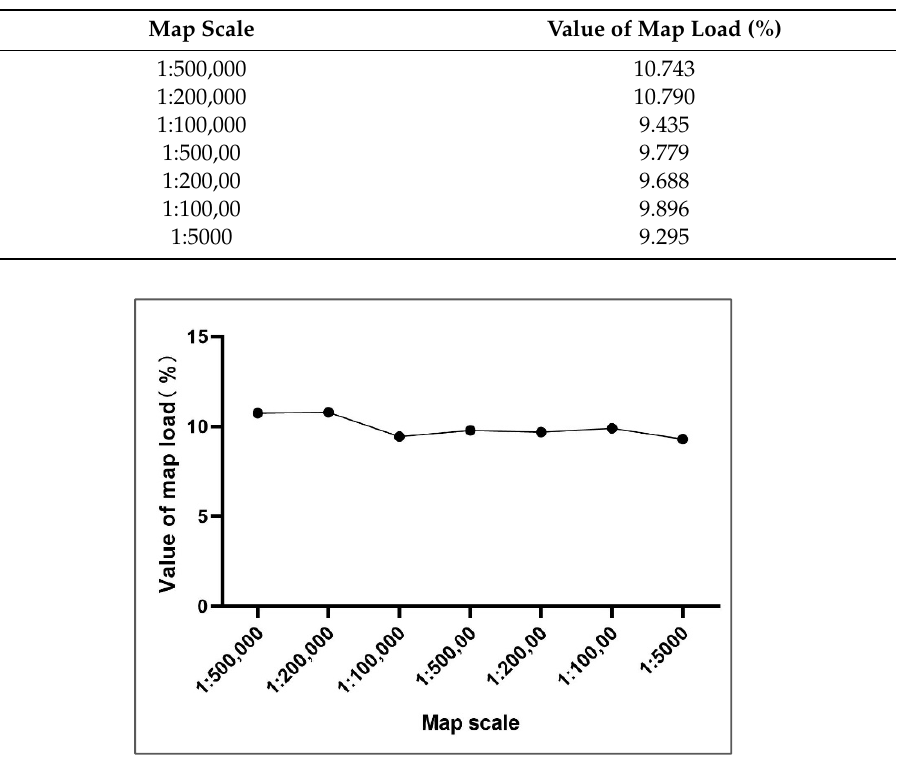
Figure 11. Line chart of map scale and value of map load. The horizontal axis represents map scale, and the vertical axis represents the value of map load.